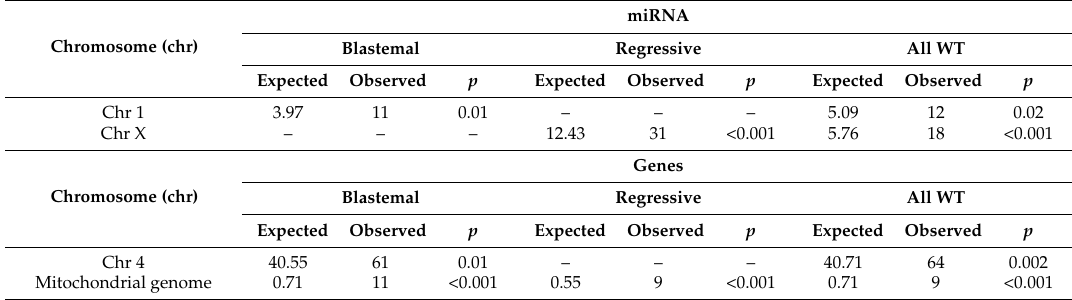
Table 4. Chromosomal enrichment analysis of miRNAs and genes downregulated in WT